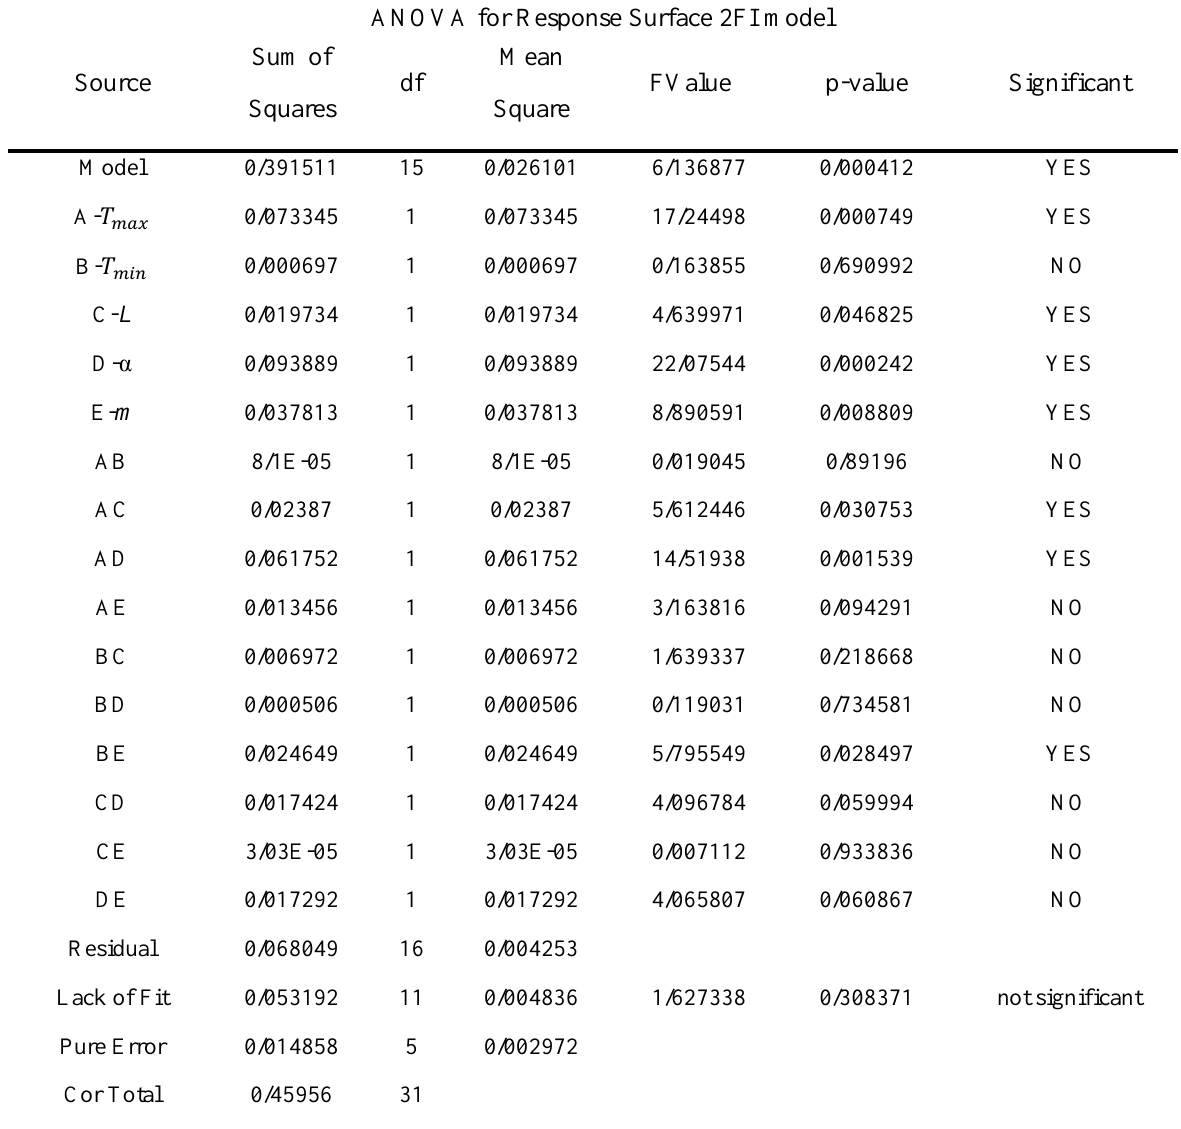
Table 5. Statistical analysis for investigating the relation between SA parameters and the computational time (EA-CSLP case